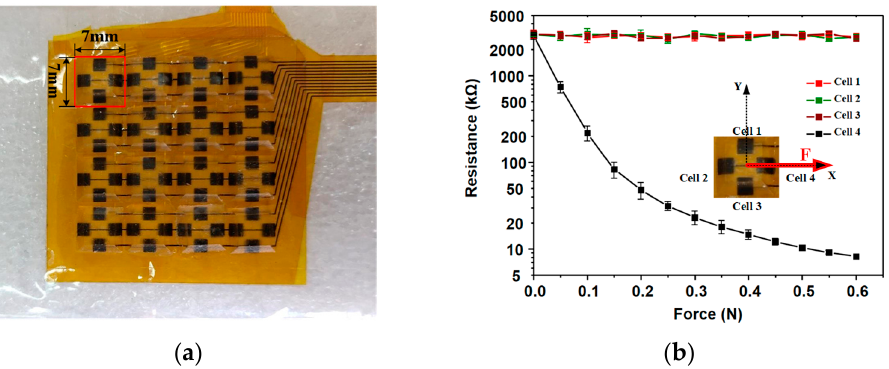
Figure 2. The arrangement and piezoresistive curve of tactile sensor array. ( a ) Photo image of the applied tactile sensor array. ( b ) Piezoresistive curve of the tactile sensor under tangential force. The arrangement of wires in the sensor array is simplified by connecting different